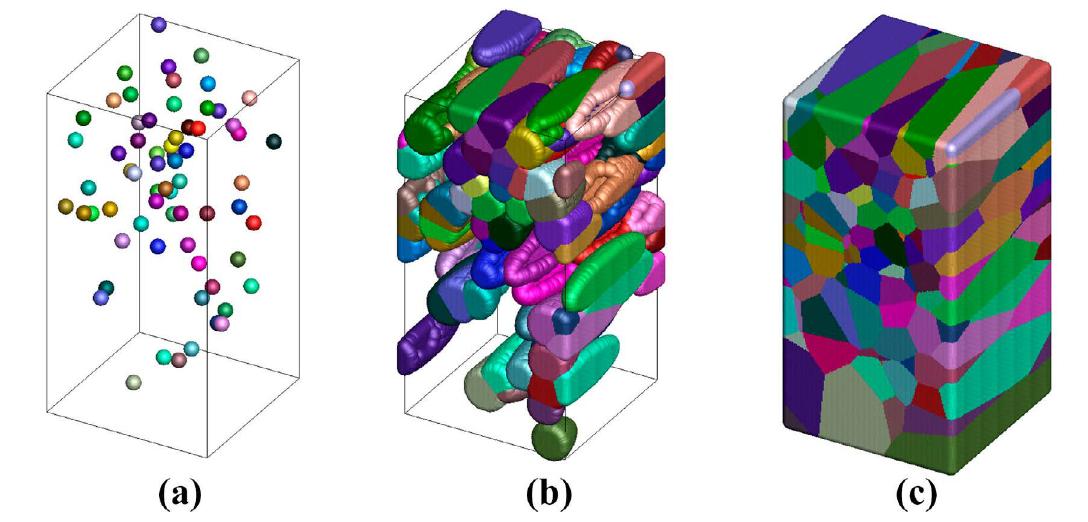
Figure 2. Computer simulated microstructures of the transformations inhomogeneous nucleated with grains that grow as prolate spheroids with aspect ratios 4:1:1: (a) V